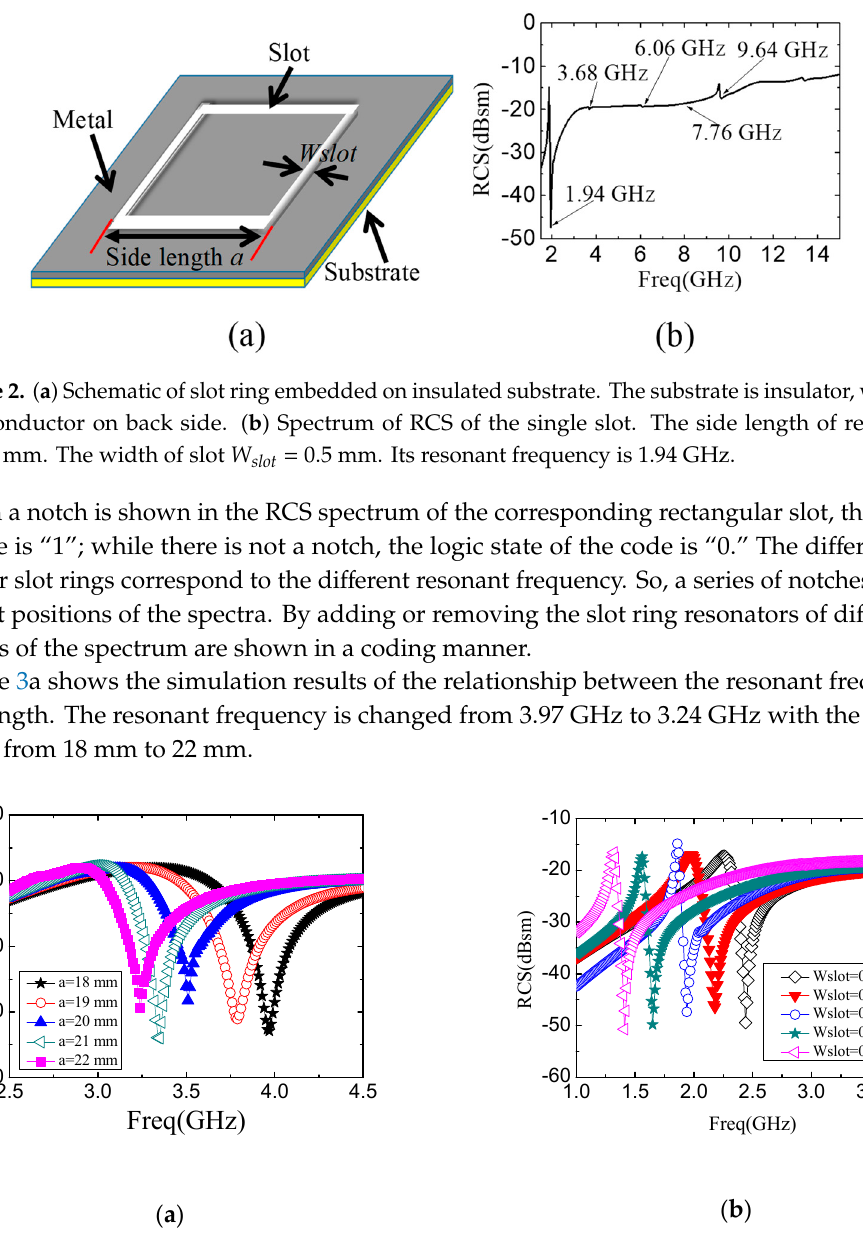
Figure 2. (a) Schematic of slot ring embedded on insulated substrate. The substrate is insulator, without any conductor on back side. (b) Spectrum of RCS of the single slot. The side length of rectangle a = 30 mm. The width of slot W slot = 0.5 mm. Its resonant frequency is 1.94 GHz.